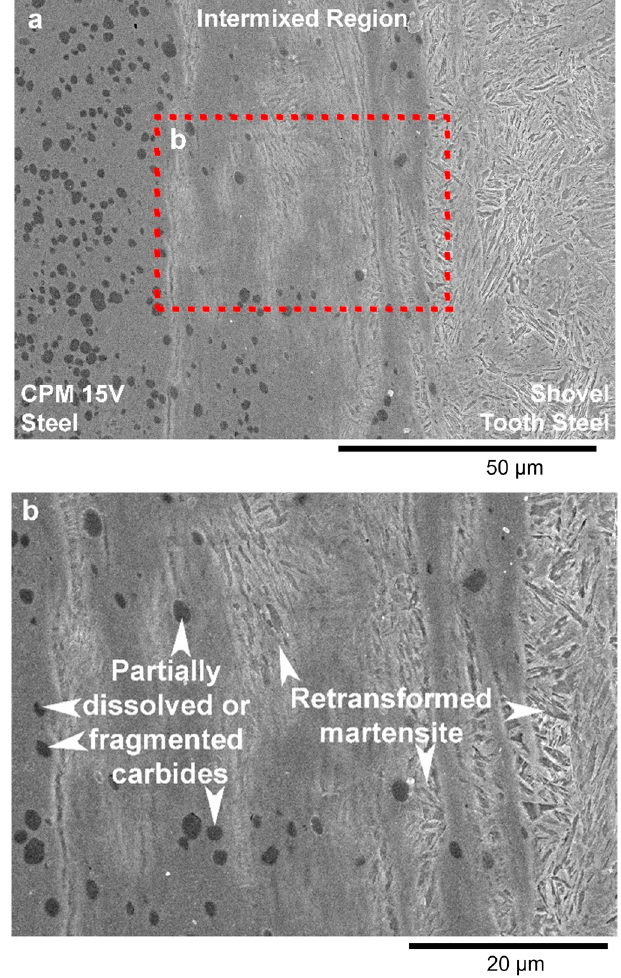
Figure 9. Representative microstructures at the interface for the HF condition observed by SEM, where ( a ) and ( b ) are different regions at the interface.